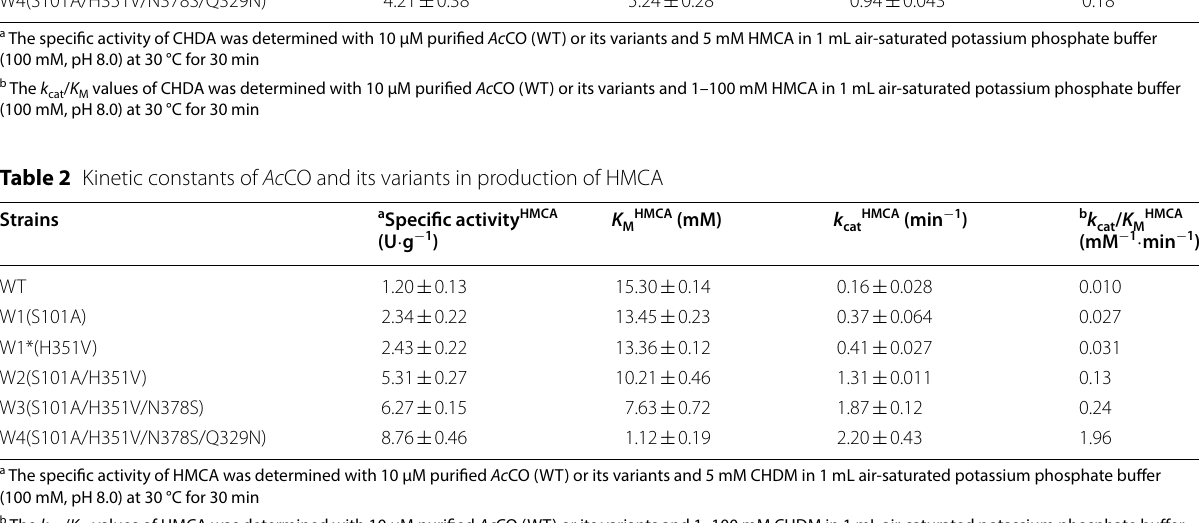
a The specific activity of HMCA was determined with 10 μM purified Ac CO (WT) or its variants and 5 mM CHDM in 1 mL air-saturated potassium phosphate buffer (100 mM, pH 8.0) at 30 °C for 30 min b The k cat / K M values of HMCA was determined with 10 μM purified Ac CO (WT) or its variants and 1–100 mM CHDM in 1 mL air-saturated potassium phosphate buffer (100 mM, pH 8.0) at 30 °C for 30 min